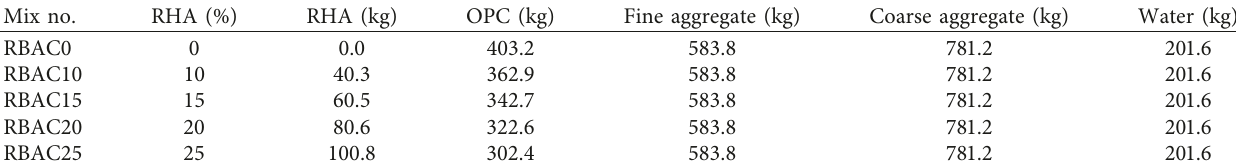
Table 3: Mix design to produce 1 m 3 of BAC containing